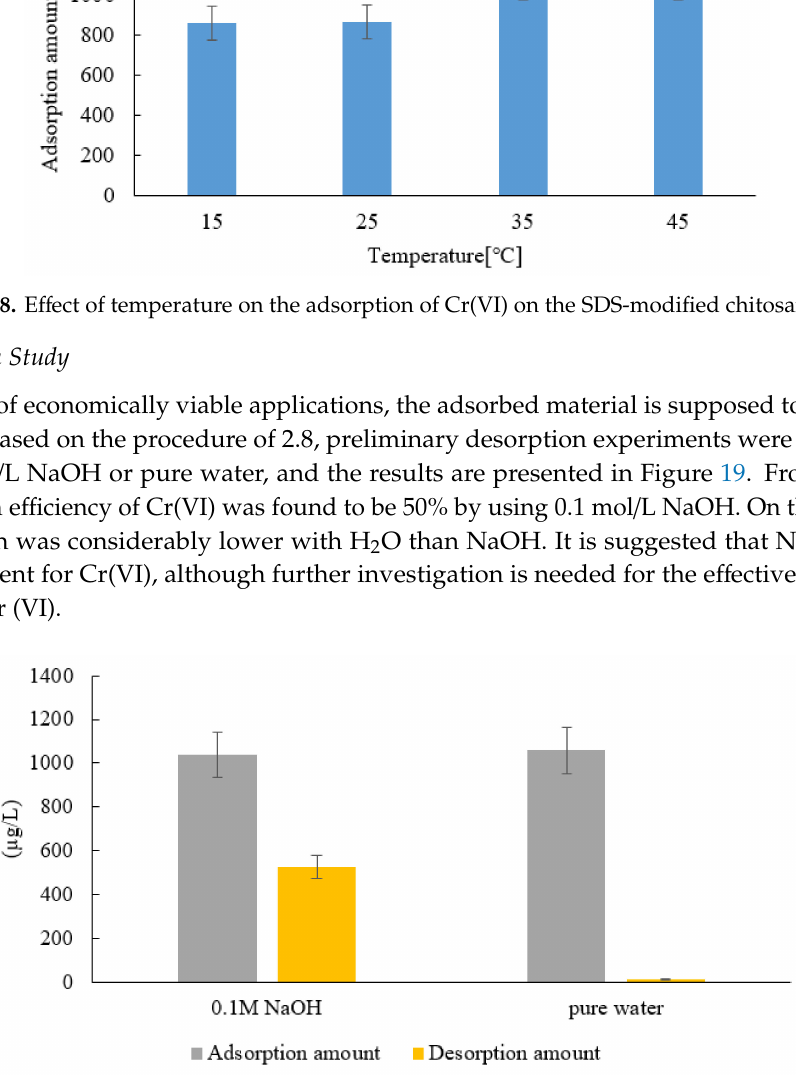
Figure 19. Desorption e ffi ciency of Cr(VI) using NaOH or pure